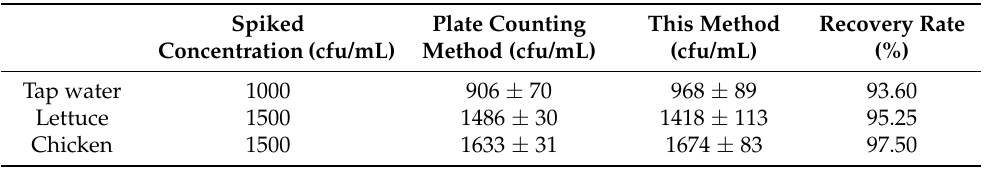
Table 1. Comparison of the detection of E. coli O157:H7 in three real samples between the surface- enhanced Raman scattering biosensor and classic plate